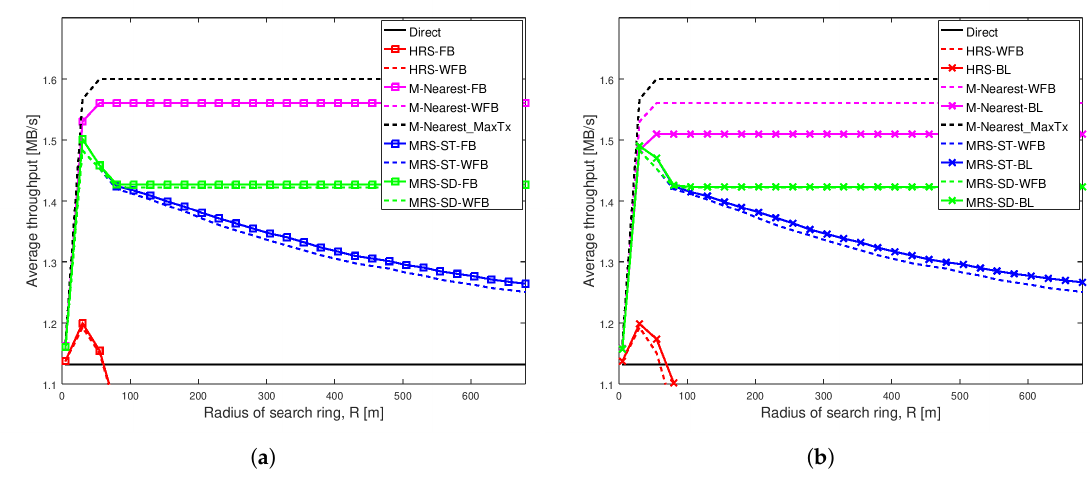
Figure A4. Average throughput of different schemes when Shape = 2 and Scale = 0.5 in a network having width of 1000 m. ( a ) Different battery power levels not considered in relay selection; ( b ) Different battery power levels considered in relay